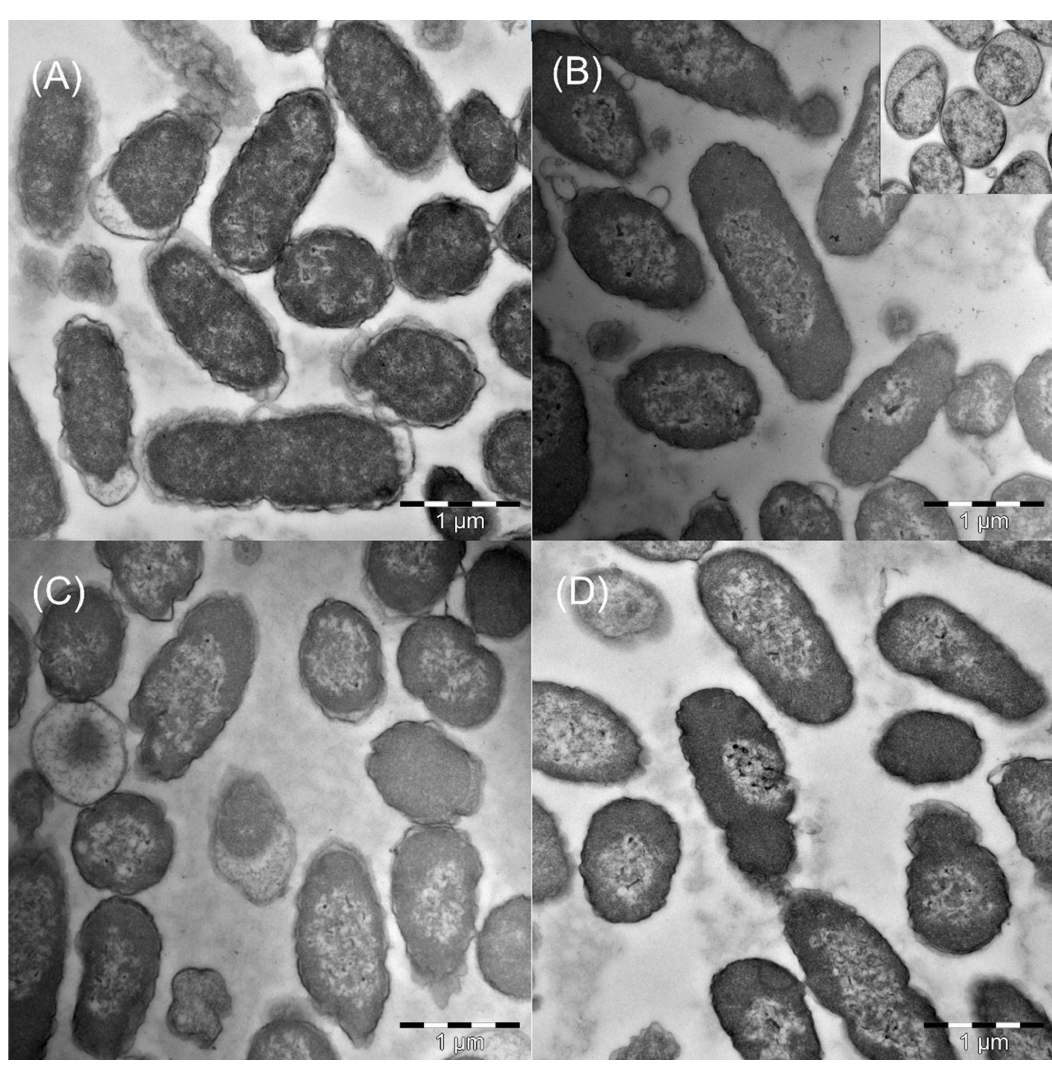
cytoplasmic material out of the cell membrane (not to